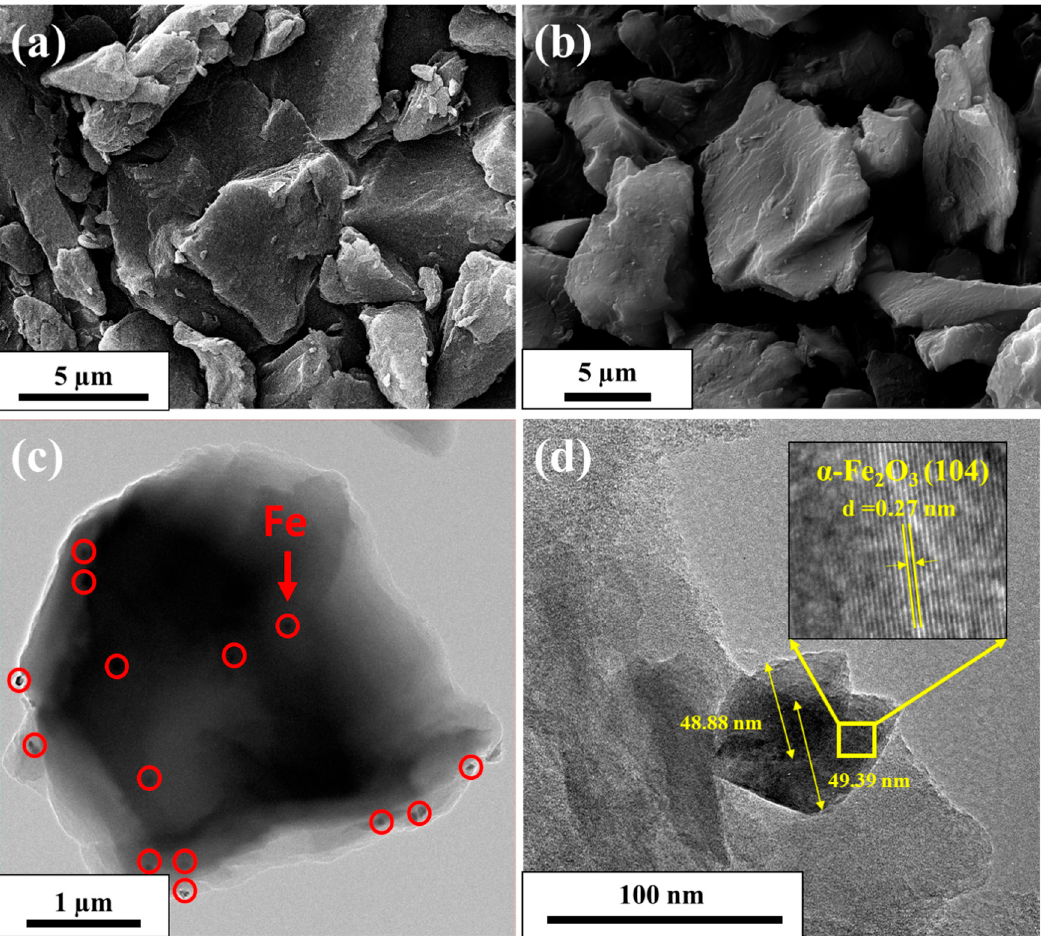
Figure 1. FE-SEM images of ( a ) AC and ( b ) AC/Fe 2 O 3 nanocomposite. ( c , d ) TEM images of AC/Fe 2 O 3 nanocomposite.